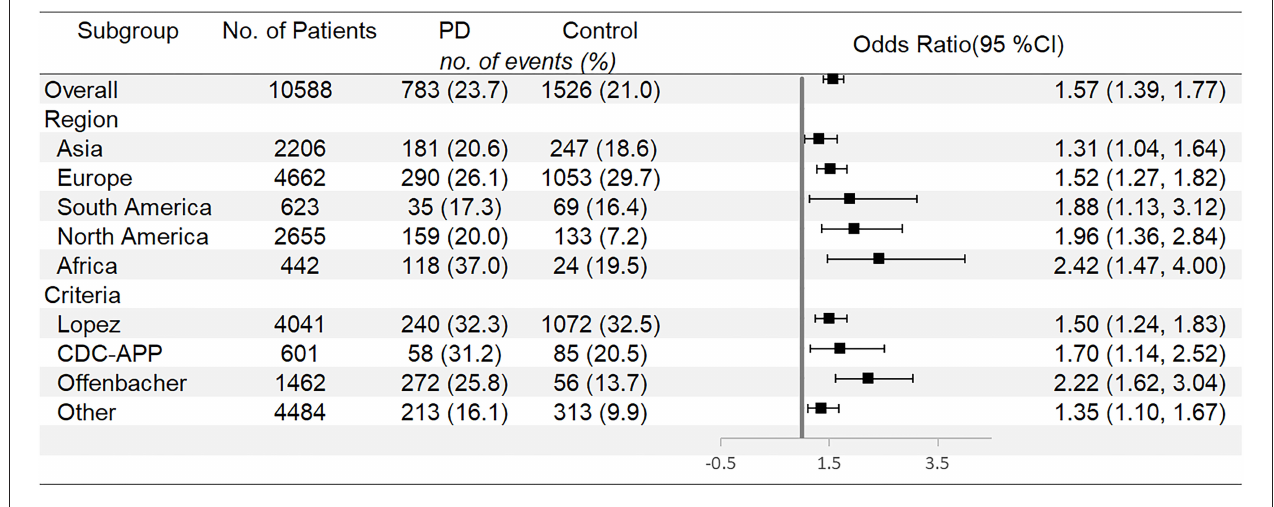
FIGURE 3 | Subgroup analyses for preterm birth.